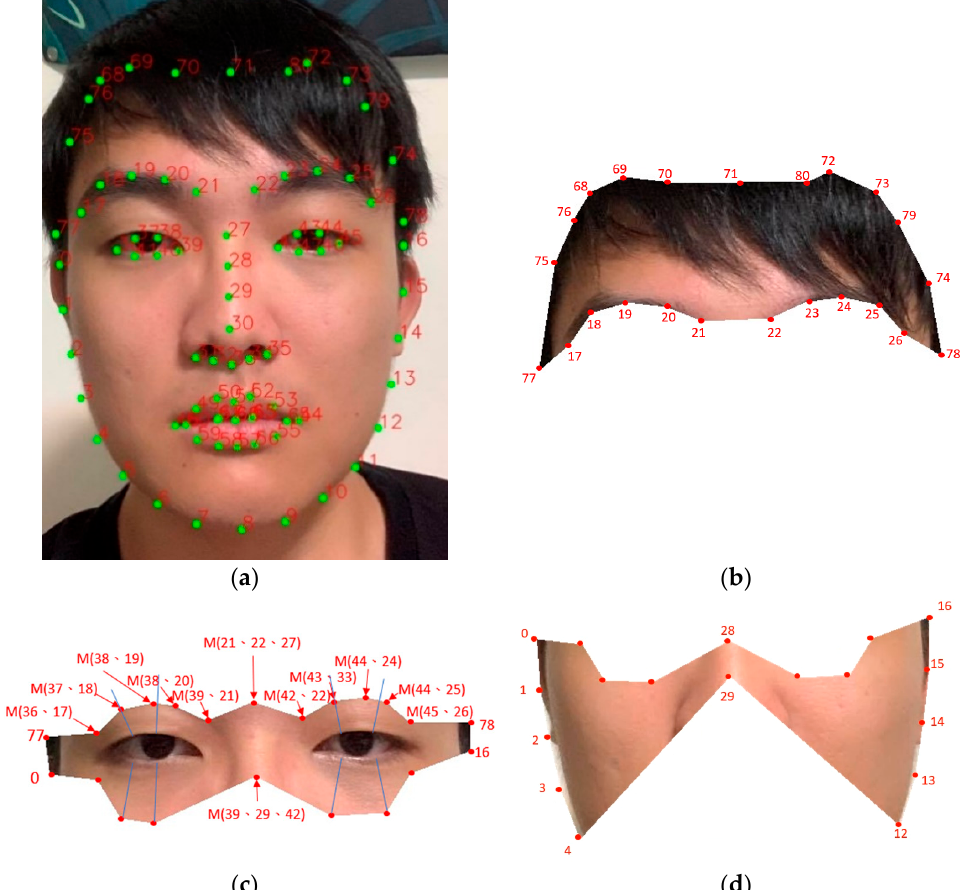
Figure 2. ( a ) A result plot produced by the 81-point model showing the point-locations in green; ( b ) Defined forehead region extracted from ( a ); ( c ) Defined eyes region; and ( d ) Defined cheeks region also extracted from ( a ).